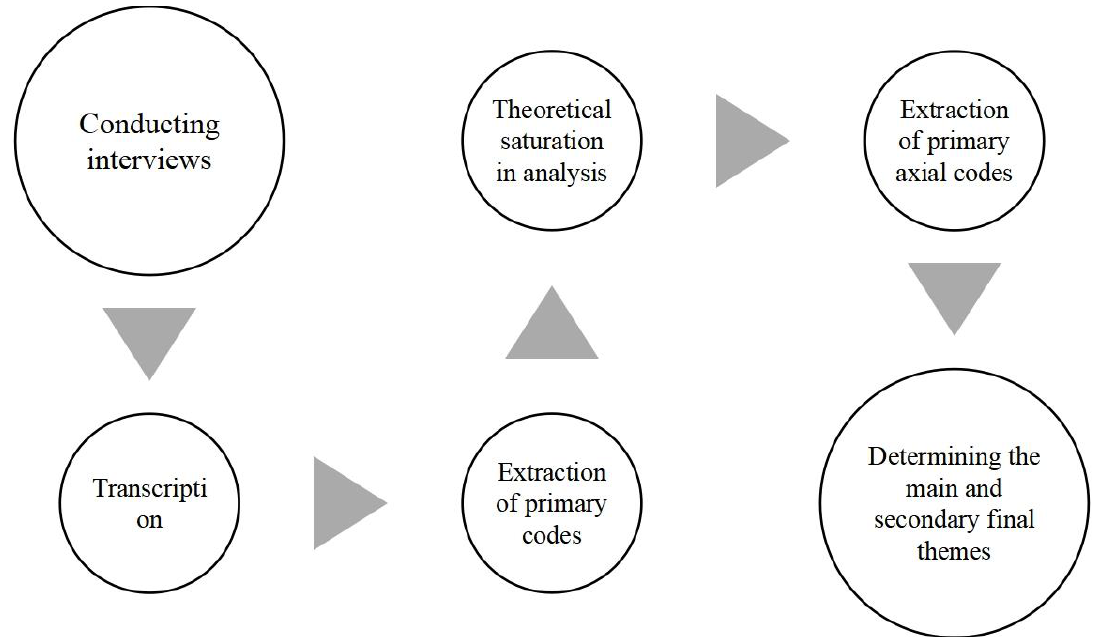
Figure 4. Process of obtaining the final themes of the model. Table 2. Theme analysis results.